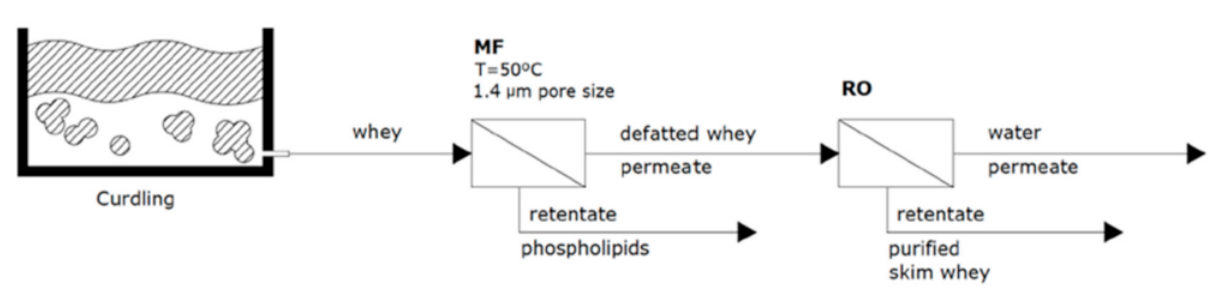
Figure 6. Whey fat reduction and purification by MF and RO membrane